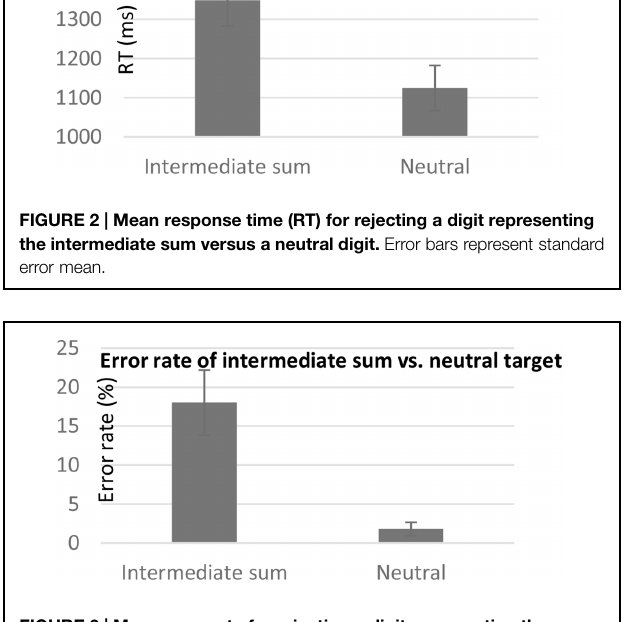
FIGURE 3 | Mean error rate for rejecting a digit representing the intermediate sum versus a neutral digit. Error bars represent standard error